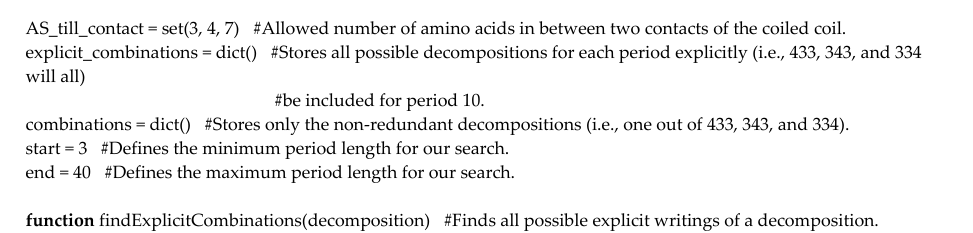
Algorithm 1: Pseudocode of a program for calculating all theoretically possible decompositions (weighted strings) of given periods into 3, 4, and 7 AS_till_contact = set(3, 4, 7) #Allowed number of amino acids in between two contacts of the coiled coil. explicit_combinations = dict() #Stores all possible decompositions for each period explicitly (i.e., 433, 343, and 334 will all)